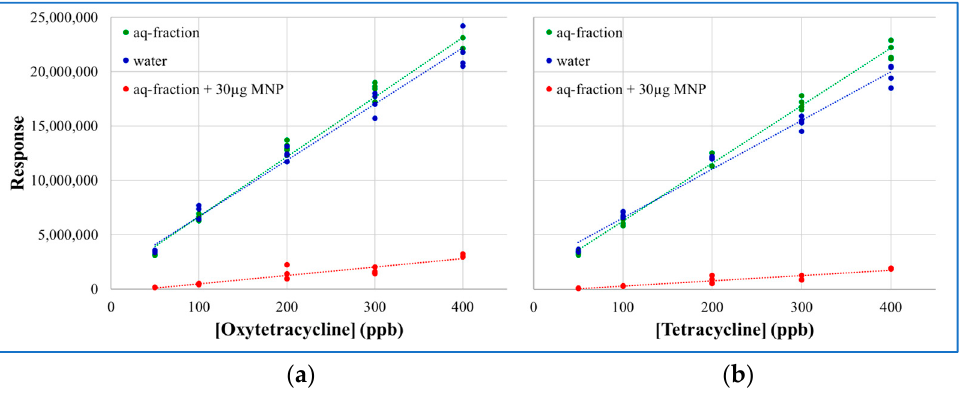
Figure 10. Calibration curves for ( a ) oxytetracycline and ( b ) tetracycline for replicate (n = 4) samples at concentrations: 50, 100, 200, 300, and 400 ppb. In water, the aqueous fraction as shown in Figure 4d and in the aqueous fraction after extraction with 30 µg MNP suspension in vial.